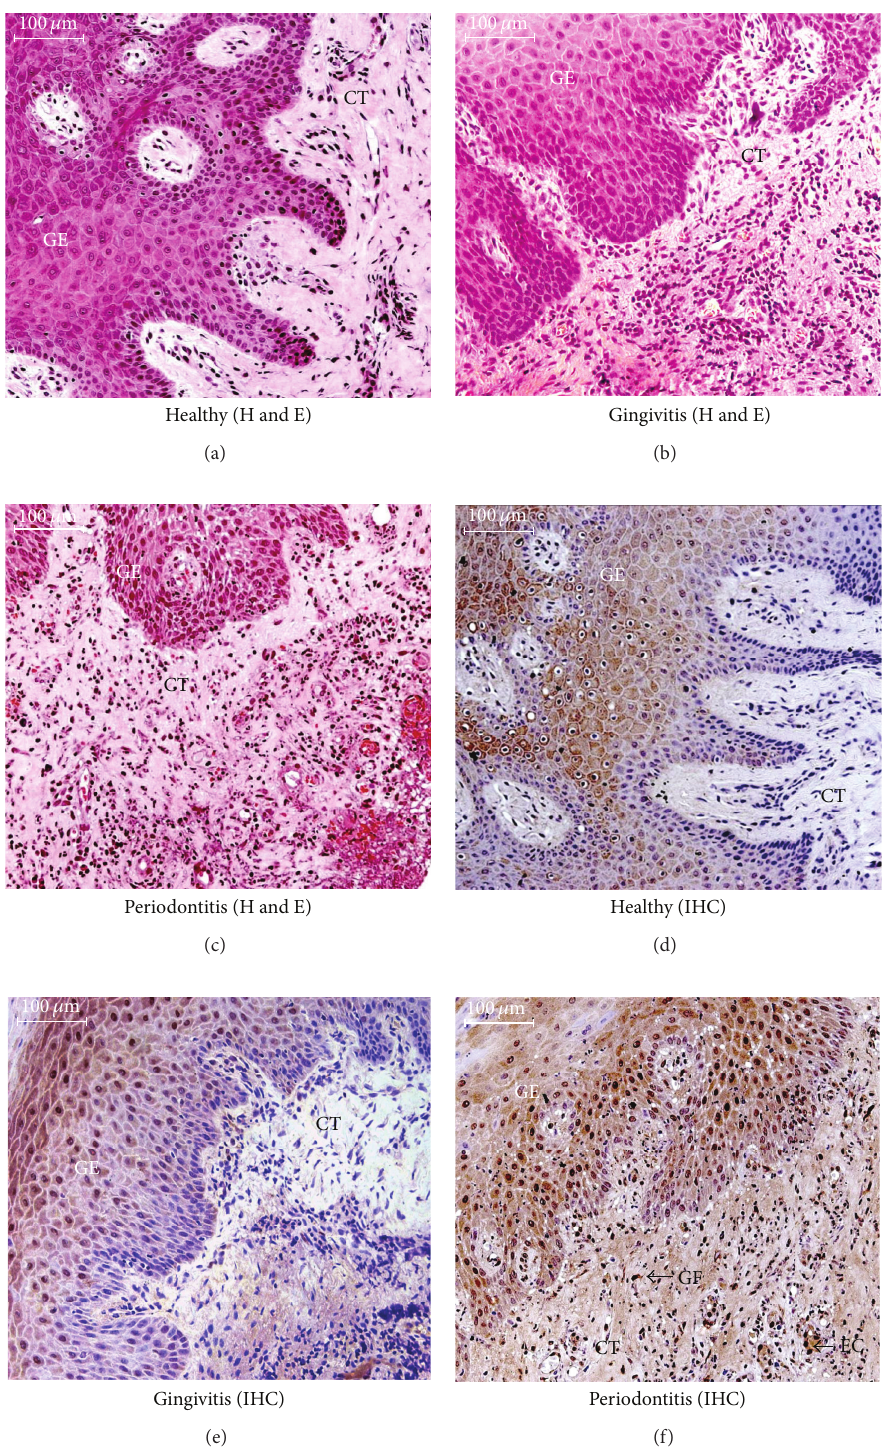
Figure 4: NAMPT protein levels in gingival biopsies. Gingiva from periodontally healthy ((a) and (d)), gingivitis ((b) and (e)), and periodontitis ((c) and (f)) subjects. Hematoxylin and eosin stain ((a)–(c)). NAMPT protein, as demonstrated by immunohistochemistry ((d)–(f)). Images from one representative individual of each group are shown. GE: gingival epithelium; CT: connective tissue, GF: fibroblast; EC: endothelial